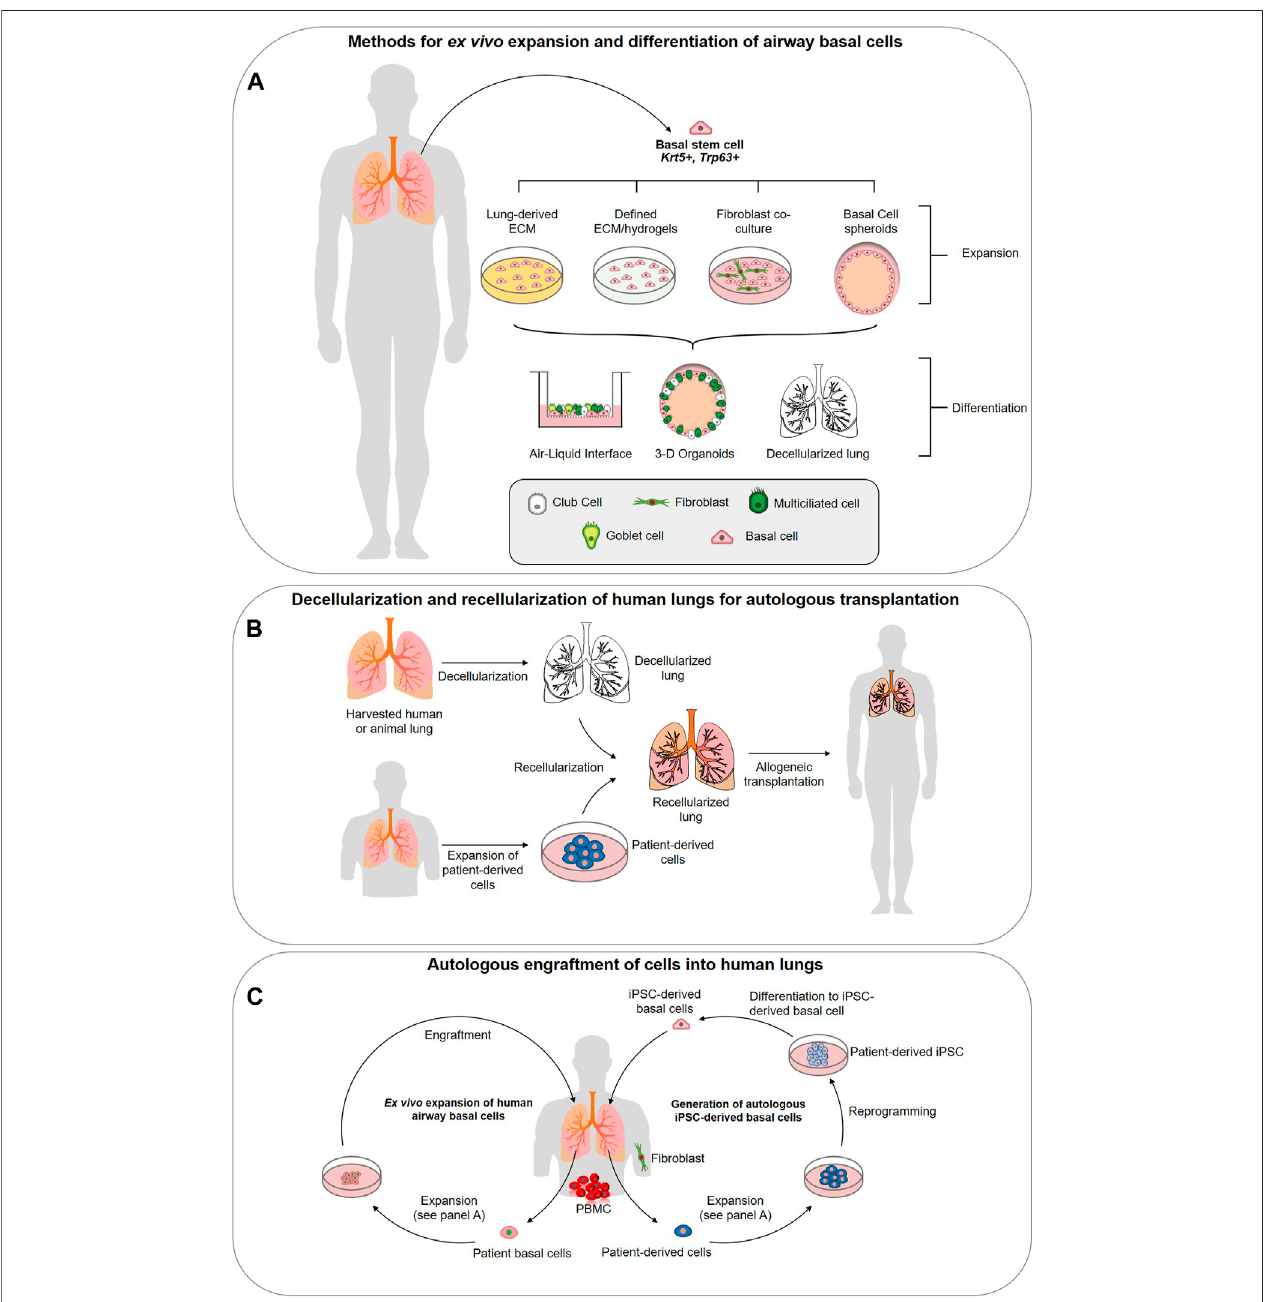
FIGURE 1 | Strategies for utilizing airway basal stem cells in regenerative medicine approaches. (A) Methods for ex vivo expansion and differentiation of airway basal cells . Basal cells (BCs) can be isolated from the human lung epithelium and expanded in 3-D culture, co-culture with 3T3 fi broblasts, or potentially on speci fi cally designed hydrogels or extracellular matrix (ECM)-derived from decellularized lungs. Expanded basal cells are capable of complete differentiation into a pseudostrati fi ed airway epithelium at the air-liquid interface, in 3-D spheroid cultures or in decellularized lung scaffolds. (B) Decellularization and recellularization of human lungs for autologous transplantation. Decellularization of human donor lungs, followed by recellularization with patient-derived cells (generated via methods described in panels c (primary airway cell expansion) and d (iPSC-derived basal cell generation. The concept is designed to achieve functional lung tissues or indeed, entire lungs, for autologous transplantation. (C) Ex vivo expansion of human airway basal cells. BCs can be isolated from human lung biopsy or bronchoscopy and expandedonde fi nedECMtomaintainstemnessandphenotype.Thegoalistoengraftthesestemcellsintothelungtorestoreairwayfunction. Generationofautologous iPSC-derived basal cells. Using accessible cells such as peripheral blood mononucleocytes (PBMCs) or fi broblasts from skin biopsies, iPSC can be generated via reprogramming. Protocolsnow exist for their precise differentiation to lung basal cells (Hawkins et al., 2020) generating apotentially unlimited source ofautologous cells for